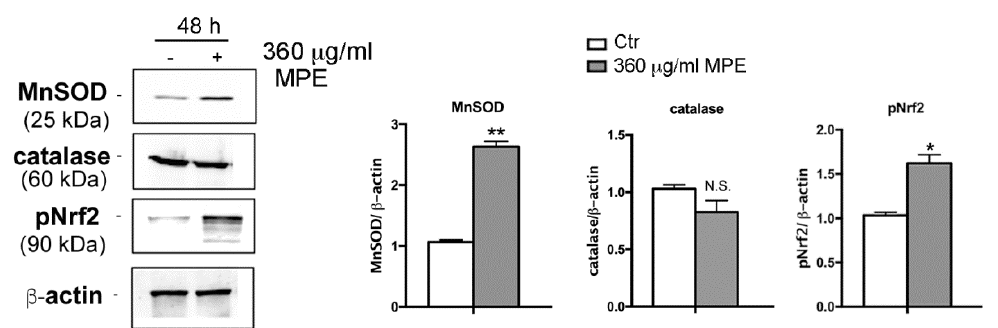
Figure 7. MPE treatment upregulates antioxidant responses. Colon carcinoma HT29 cells were exposed to MPE treatment for 48 h. Then, cells were lysated and proteins were analyzed using western blotting by using specific antibodies directed against MnSOD, catalase and Nrf2, as reported in Materials and Method section. The correct protein loading was ascertained by immunoblotting for β -actin. Representative blots of three independent experiments and densitometry analysis histograms are depicted. (*) p < 0.05 and (**) p < 0.01 compared to the untreated sample. N.S., not significant.